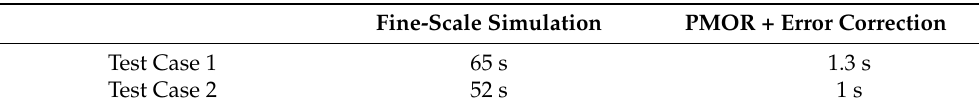
Table 9. Time (seconds) comparison for the two test cases between fine-scale simulation and reduced- order model with error correction.